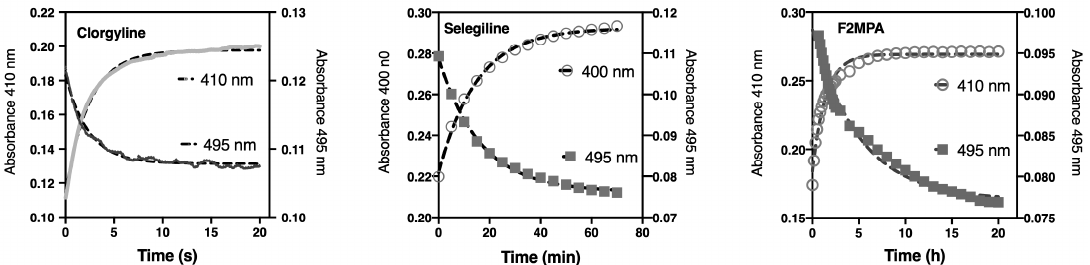
Figure 7. Time courses for absorbance changes in MAO-A incubated anaerobically with propargylamine inactivators. The rate of reduction (decrease in absorbance at 495 nm) and the rate of adduct formation (increase at 410 nm) at 20 ° C were measured by stopped-flow spectrometry for clorgyline, but the time courses for selegiline and F2MPA were extracted from a timed collection of spectra in a Unvikon2101 spectrometer. Left : clorgyline (50 μ M) forms the adduct almost as fast as it reduces MAO-A (19.5 μ M). The rates were 29.0 ± 4.1 min − 1 at 410 nm and 35.9 ± 3.5 min − 1 at 495 nm. Middle : selegiline (500 μ M) also forms the adduct and reduces MAO-A (22 μ M) at similar monophasic rates (0.016 ± 0.003 and 0.019 ± 0.002 min − 1 , respectively). Right : F2MPA (2 mM) with MAO-A (22 μ M) gives a monophasic increase at 410 nm but a biphasic decrease in absorbance at 495 nm, requiring more than 21 h for completion.